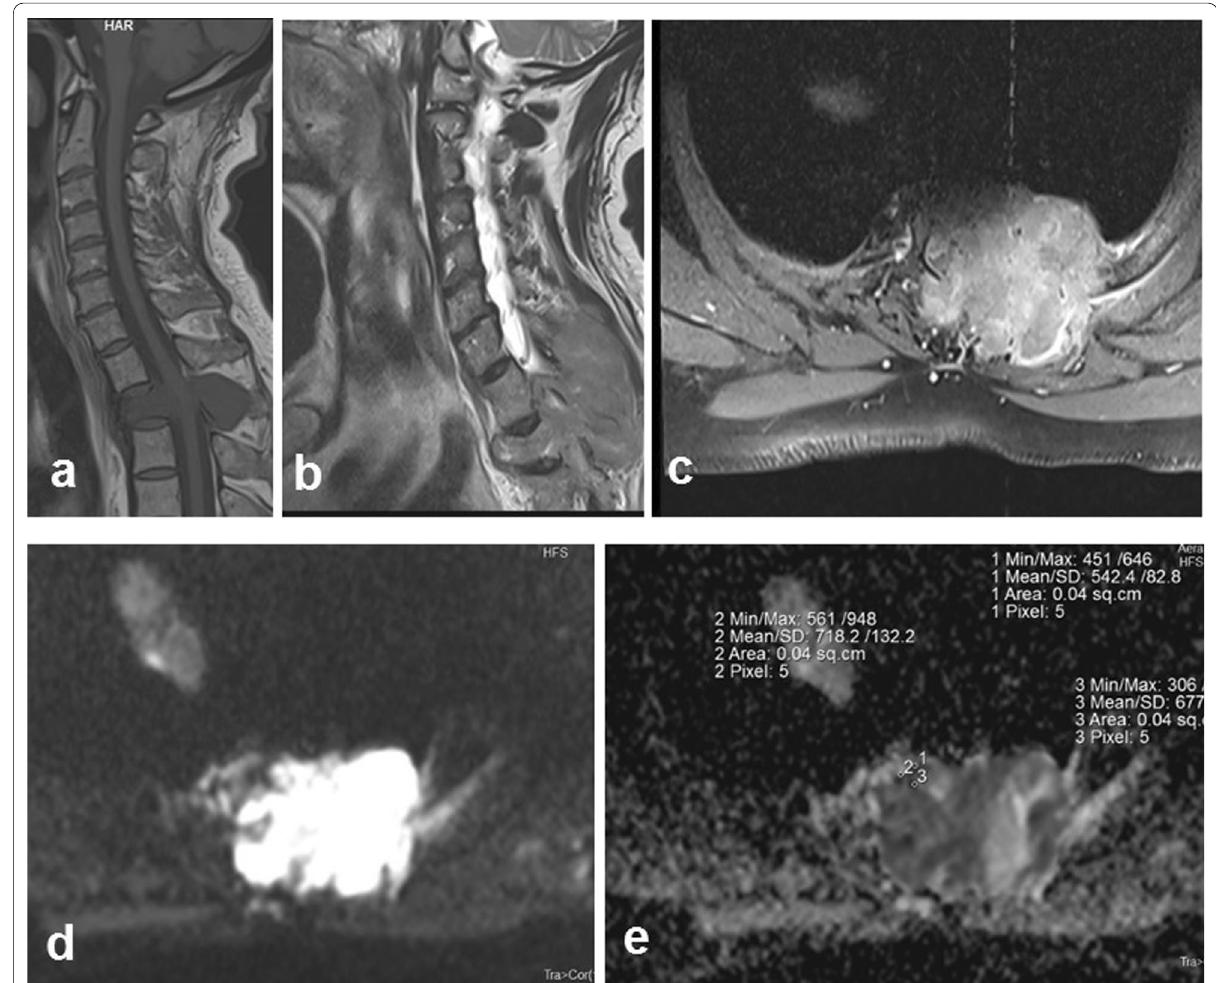
Fig. 2 A 64-year-old man with metastatic hepatic sarcoma. Sagittal T1 ( a ) and T2 ( b ) images show the partially collapsed D2 with metastatic lesion and large left sided extra-osseous soft tissue component, being, respectively, hypo- and iso-intense with respect to the surrounding tissue. Post-contrast axial T1 ( c ) shows homogenous post-contrast enhancement. The corresponding axial DWI image ( d ) demonstrates bright signal denoting restricted diffusion that shows on ADC map ( e ), mean value of